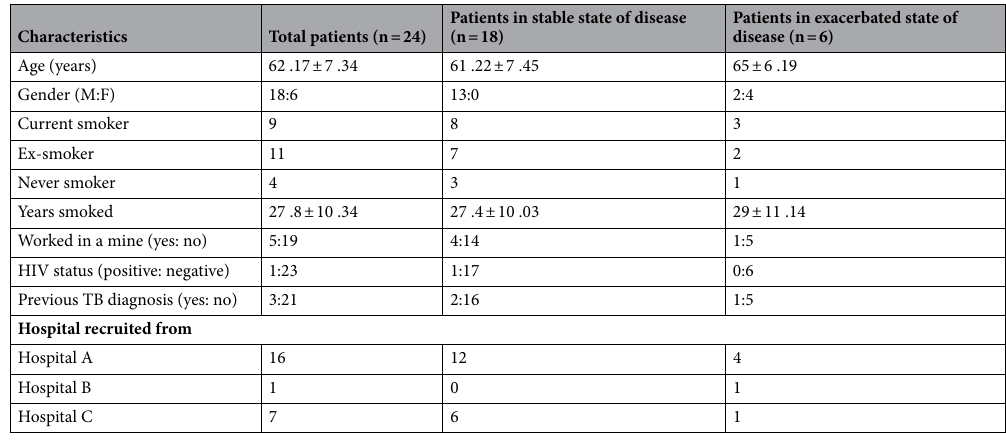
Table 1. Clinical characteristics of COPD participants.